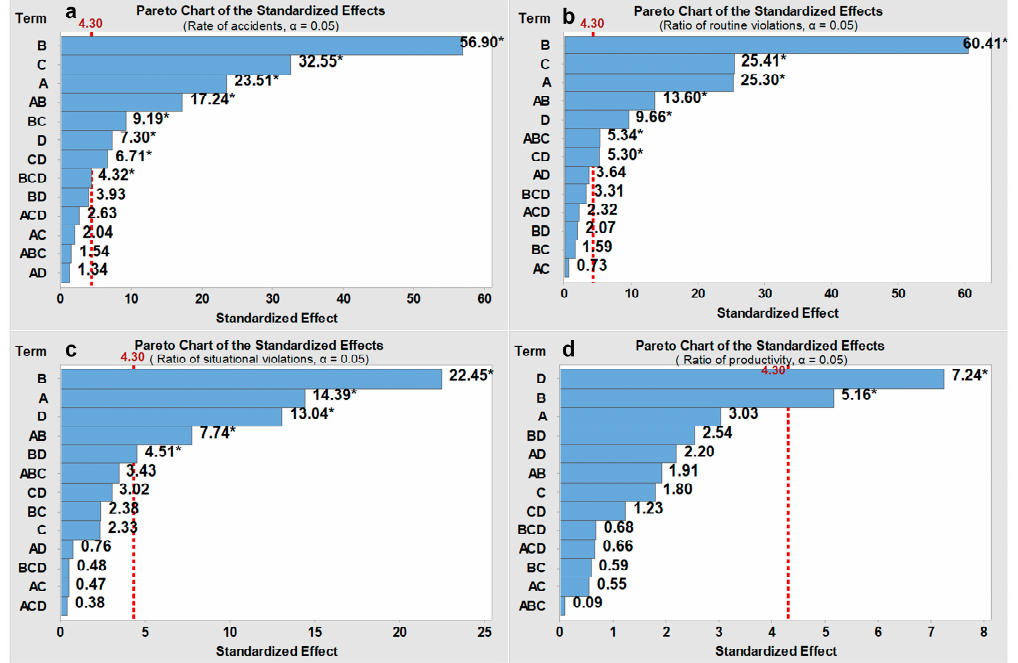
Figure 10. Pareto charts of the standardized effects for the “low” hazard onsite conditions. Note: ( a ) = safeGoal; ( b ) = proacMan; ( c ) = median contagionPro; ( d ) = productionIncr; * = p < 0.05.